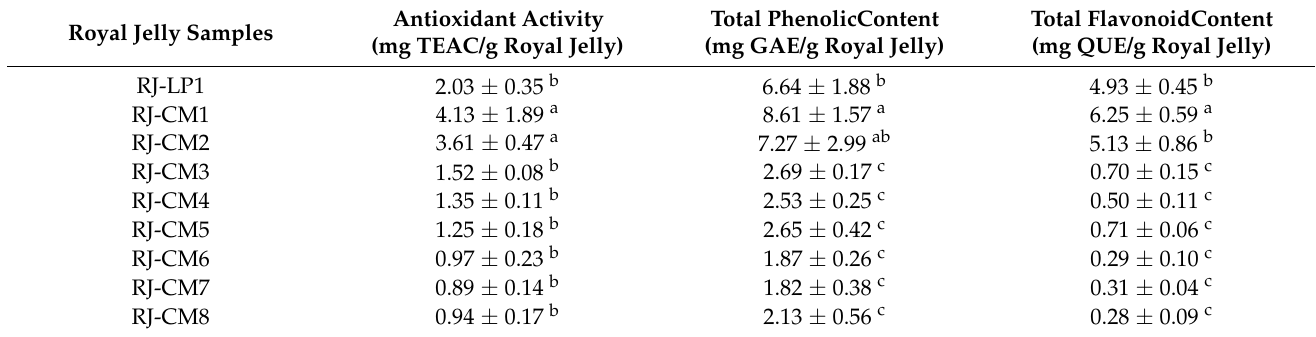
Table 4. Antioxidant activity, total phenolic, and total flavonoid content of the royal jelly samples. Antioxidant Royal Jelly Samples